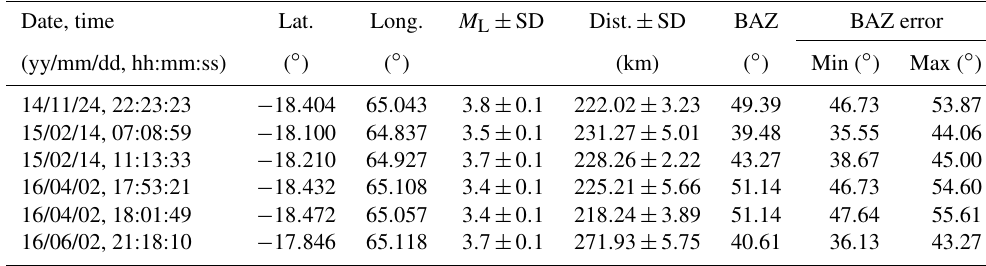
Figure 8. Array analysis of an event of 14 February 2015 at 07:08:55UTC that occurred close to the CIR, east of Rodrigues Island, which is listed in the USGS catalogue. (a) Vertical-component traces. (b) Zoom-in of the P waveforms. (c) Beam energy as a function of horizontal slowness components s x and s y . (d) Shifted traces and beam (red trace) corresponding to the maximum indicated in (c) . The back azimuth of this event is determined at about 39 ◦ with an apparent velocity of 9.5kms − 1 . Table 1. Events from USGS catalogue located using the Rodrigues